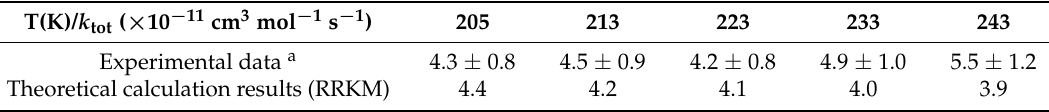
Table 1. At 150 Torr, experimental data and the theoretical calculation results of the total reaction rate constant ( k tot